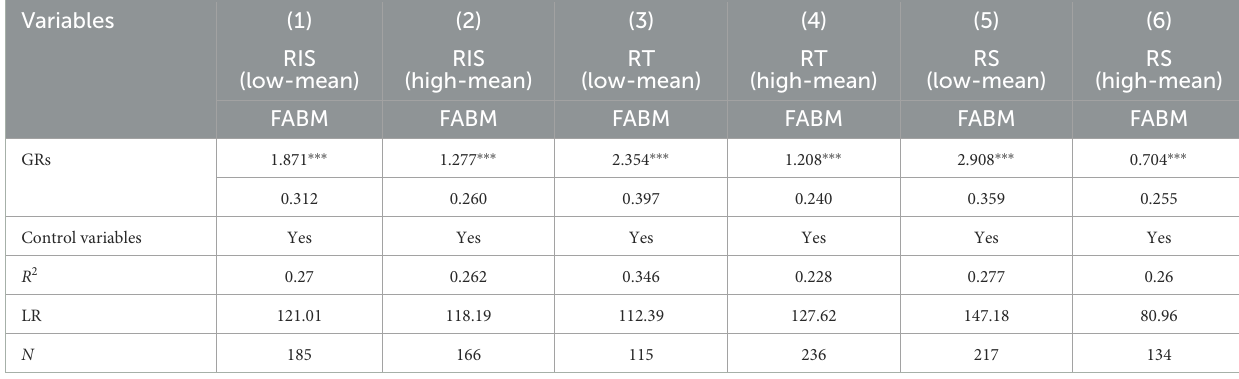
TABLE 8 Effects of different groups of GRs on farmers’ adoption of biosecurity measures.